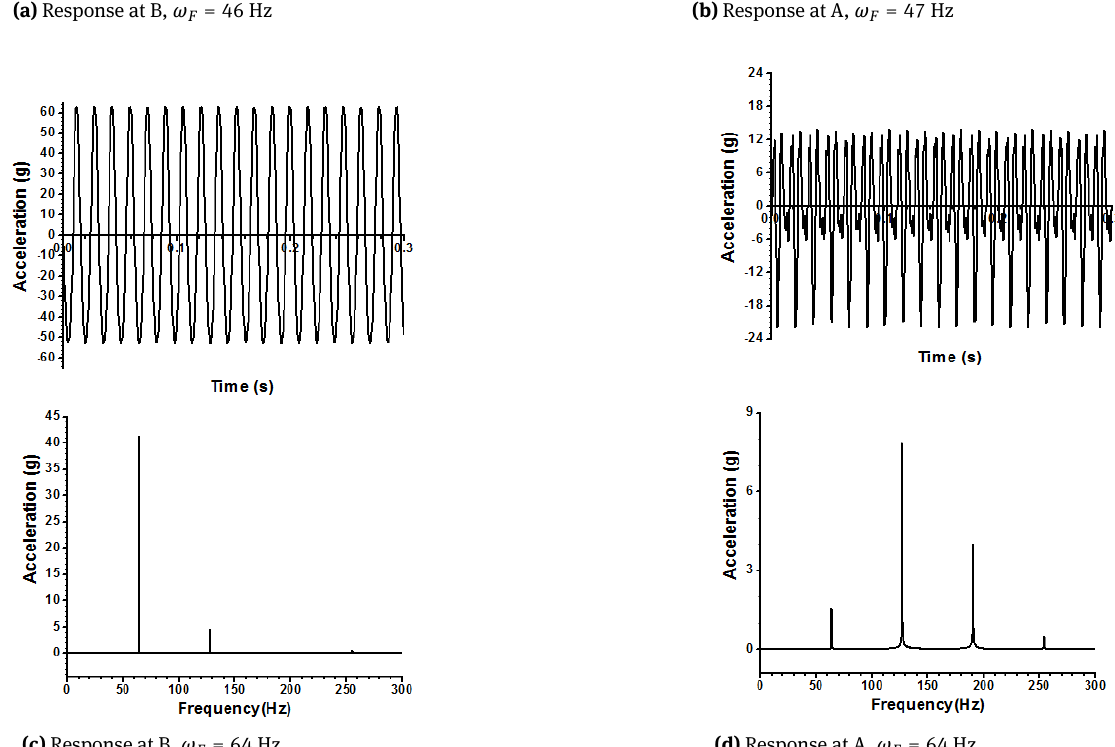
Figure 4: Steady state response history and frequency spectra of curved beam of span angle 80 ∘ excited at location B (excitation amplitude = 3.5